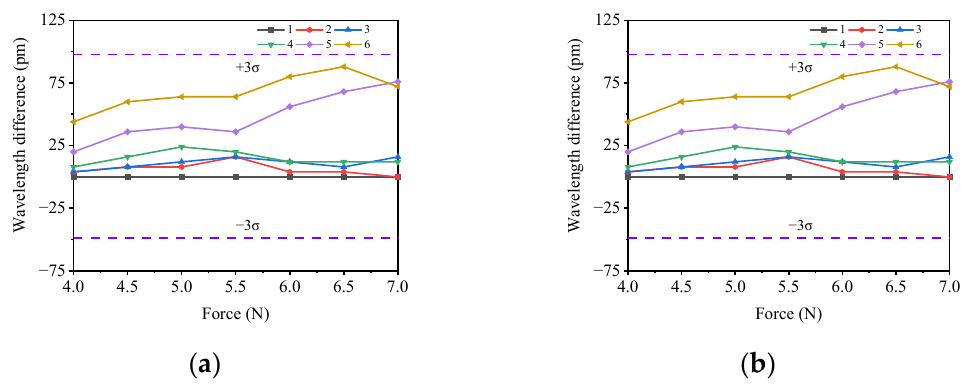
Figure 12. Residual distribution of wavelength drift: ( a ) split point, ( b ) right peak.